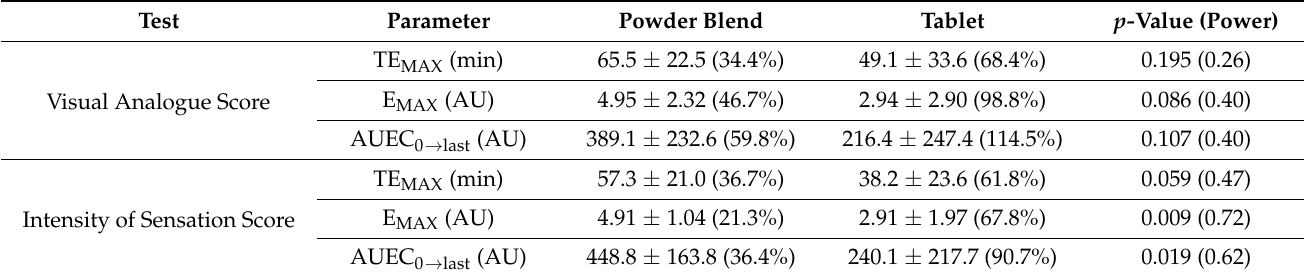
Figure 3. Mean effect intensity time profile (upper panels) and hysteresis plots (lower panels) obtained with the Visual Analog Score (A) and the Intensity of Sensation Score (B) scales for both formulations. Error bars in the hysteresis plots have been omitted for clarity. Figures in the upper panel represents the mean and positive SD. Table 2. Model independent analysis of the paresthesia effect of β -alanine in a powder blend or tablet.